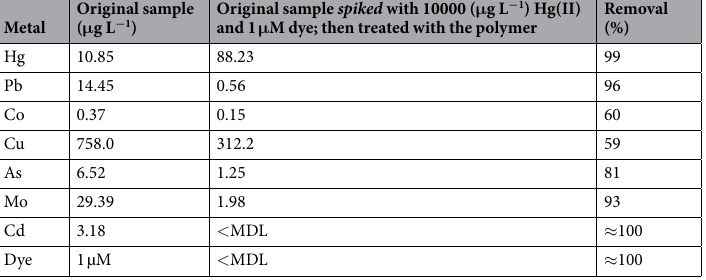
Table 4. Comparison of Hg(II) and dye concentrations in the wastewater sample before and after treatment with the polymer. MDL: the method detection